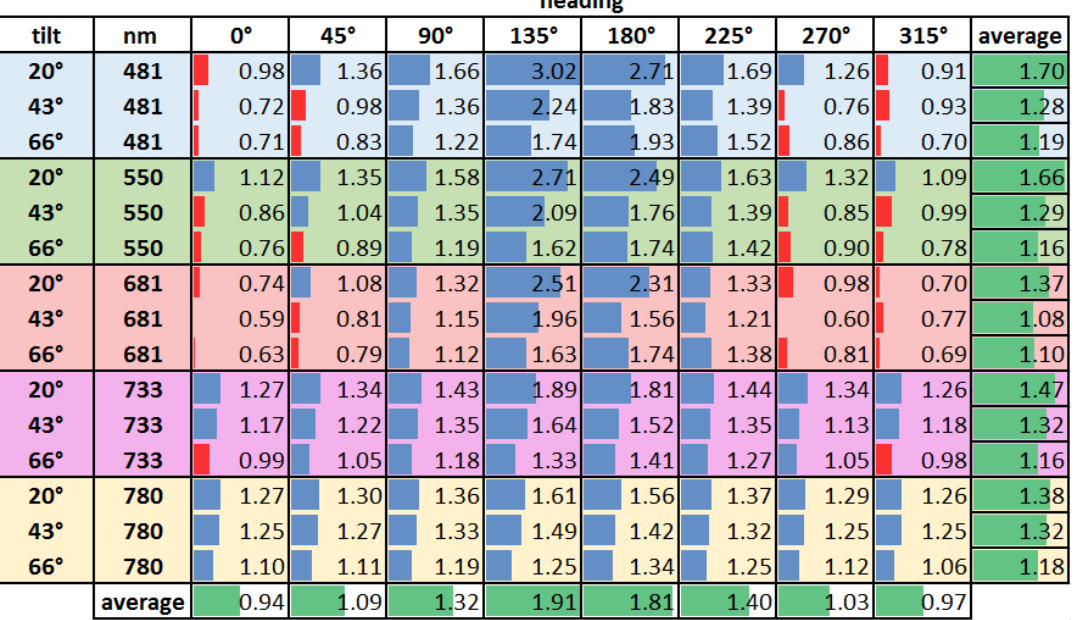
Figure 8. Normalized nadir anisotropy factor (ANIF) values for five characteristic wavelengths in the blue (480 nm), green (550 nm), red (680 nm) spectral bands; red-edge-inflection-point (REIP) (733 nm) and near-infrared (NIR) (780 nm) for 20°, 43° and 66° tilt, as well as all headings together with their average values. Values greater than 1 (blue bar) represent spectral reflectance measurements greater than nadir; values below 1 (red bar) represent measurements less than nadir. The suns azimuth was 155° and elevation